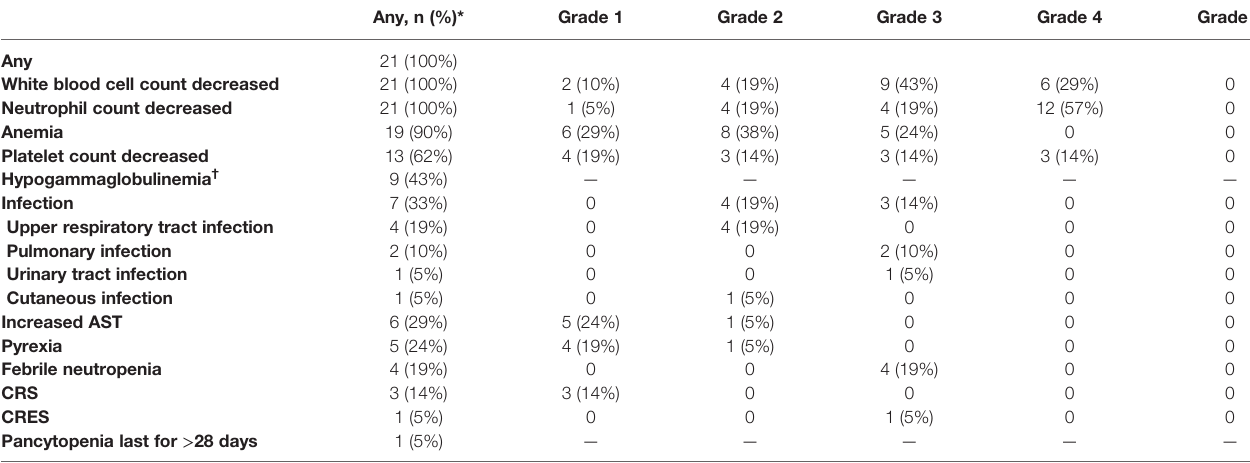
FIGURE 6 | CAR-T cell expansion in vivo and its relation with response. (A) Individual concentration-time pro fi le in all patients. (B) Survival time of CAR-T cells in vivo in responders and nonresponders. (C) The peak ratio of CAR-T cells to PBMCs in vivo in responders and nonresponders. (D) The time to maximum CAR level in peripheral blood. PBMCs, peripheral blood mononuclear cells. CR, complete response; PR, partial response; SD, stable disease; PD, progressive disease. TABLE 3 | Adverse events of interest in the